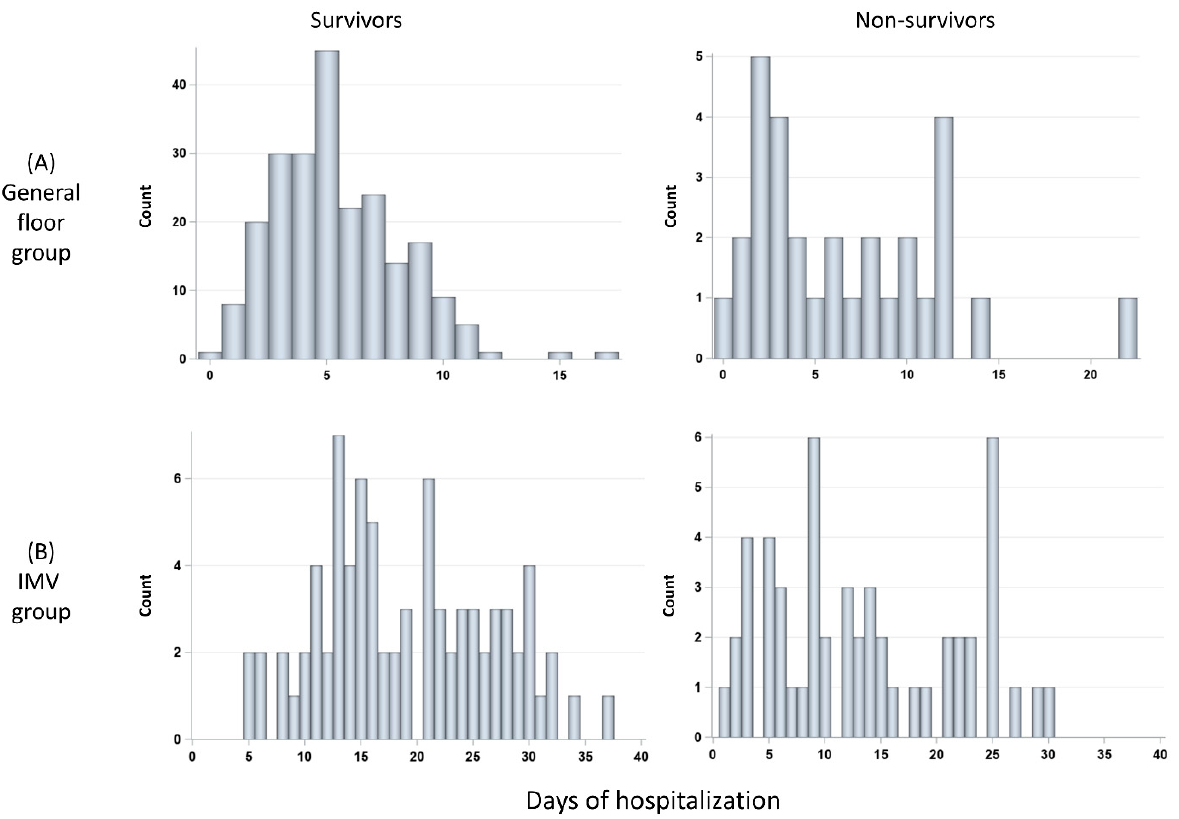
Figure 5. Histograms of days in the hospital for ( A ) GF group: survivors ( N = 228) and non-survivors ( N = 30), and ( B ) invasive mechanical ventilation (IMV) group: survivors ( N = 85) and non-survivors ( N = 58).